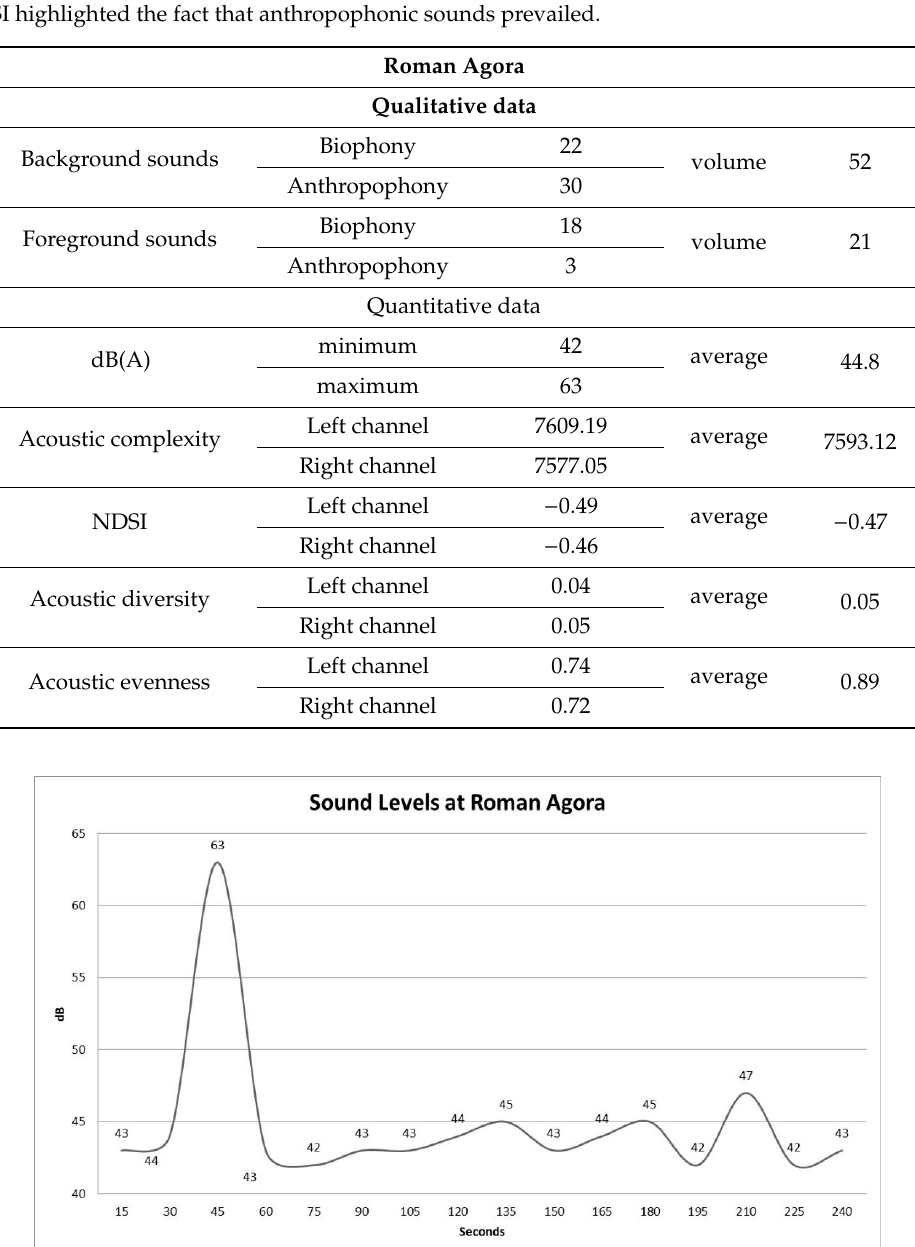
Table 2. The indicators resulted from the Roman Agora sound recording. The negative sign in the